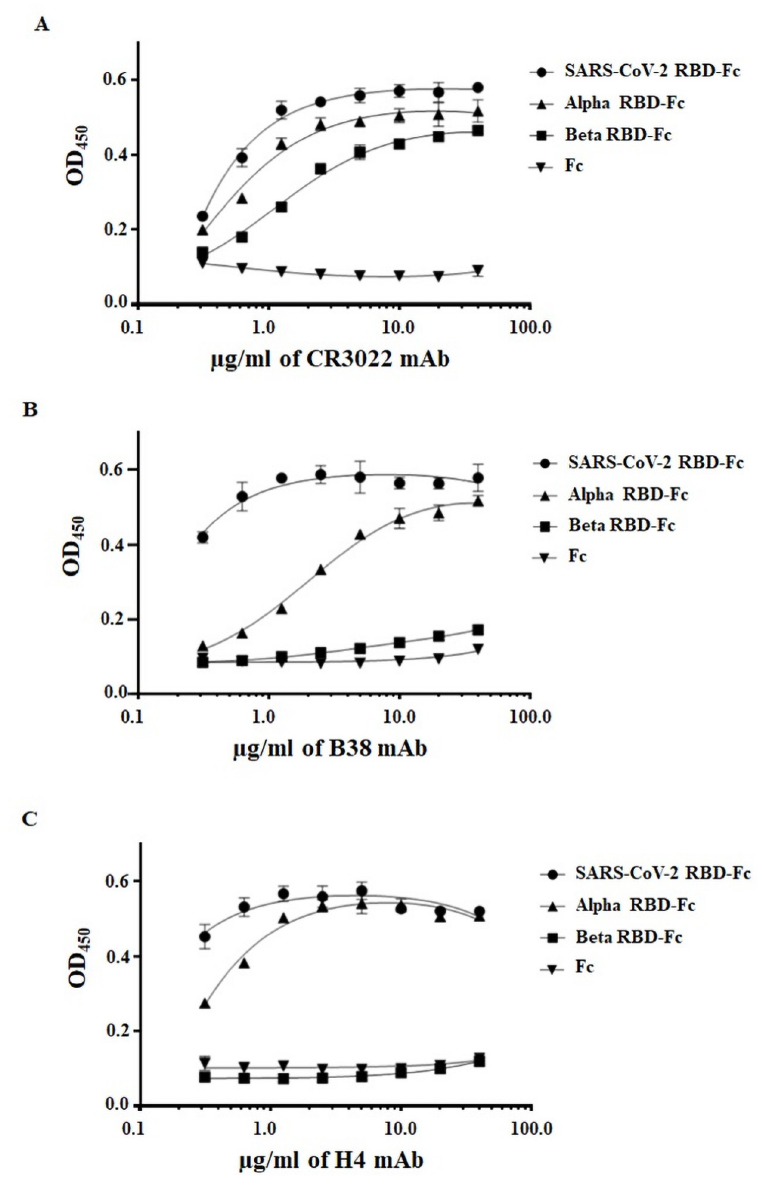
Fig 5. In vitro binding of purified plant-produced SARS-CoV-2 RBD-Fc and variants to mAbs against SARS- CoV-2 RBD. The binding affinity of plant-produced mAbs to plant-produced SARS-CoV-2 RBD-Fc and variants was determined by ELISA. The different concentration of anti-SARS-CoV mAb CR3022 (A) and anti-SARS-CoV-2 mAbs B38 (B), and H4 (C) were incubated on plates coated with plant-produced SARS-CoV-2 RBD-Fc, Alpha RBD-Fc, Beta RBD-Fc, and Fc proteins. The bound antibody was detected with HRP-conjugated goat anti-human Kappa. The data are the mean ± SD of triplicates assay from each concentration.